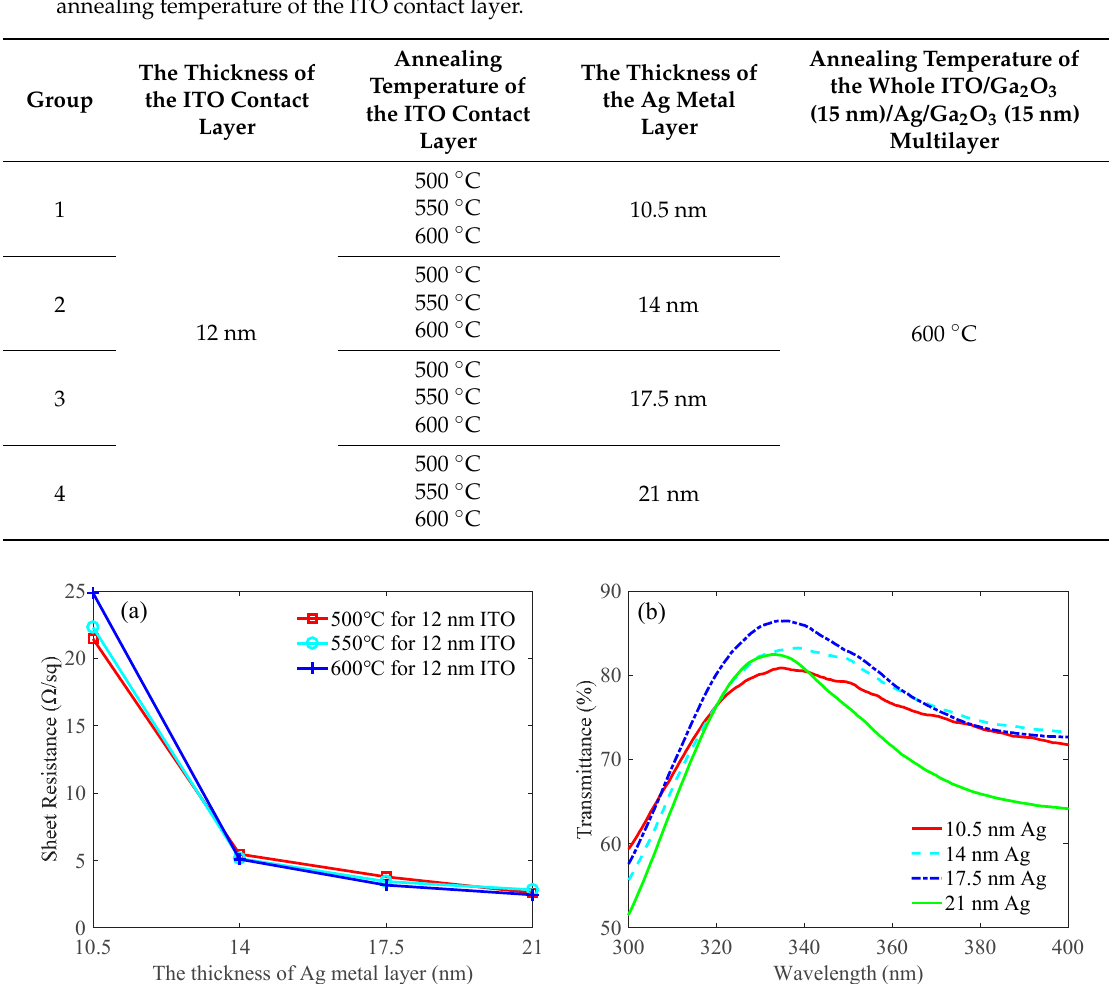
Table 1. The experimental design matrix for optimal thickness of the Ag metal layer and optimal annealing temperature of the ITO contact layer.